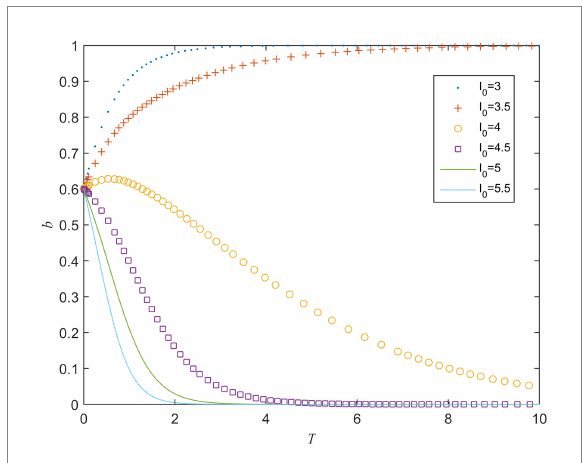
FIGURE 1 Strategy evolution of the public sector under different values of 0 I .